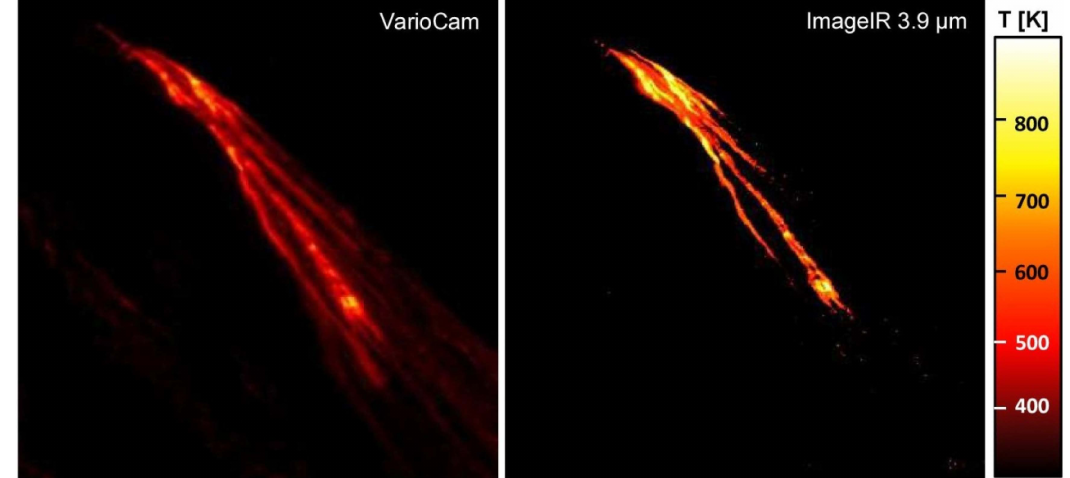
Figure 4. A comparison of the TIR and MIR observations from a boat on 20 September 2014 at 19:39:39; VarioCam data were resampled to the resolution of the ImageIR.